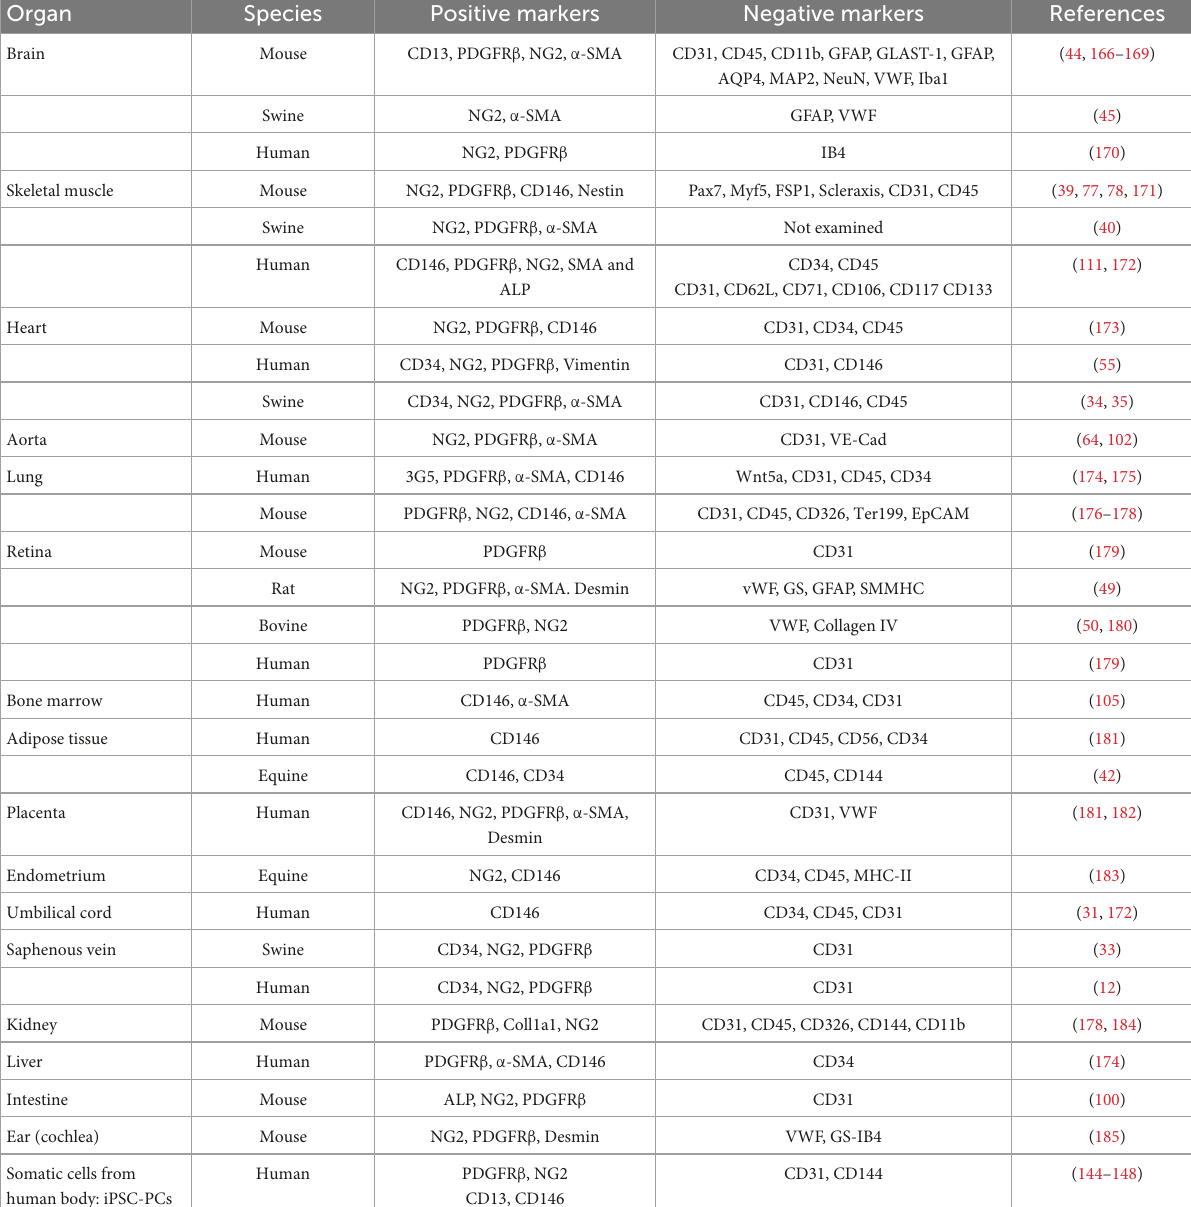
TABLE 1 Positive and negative pericytes’ markers in different species and